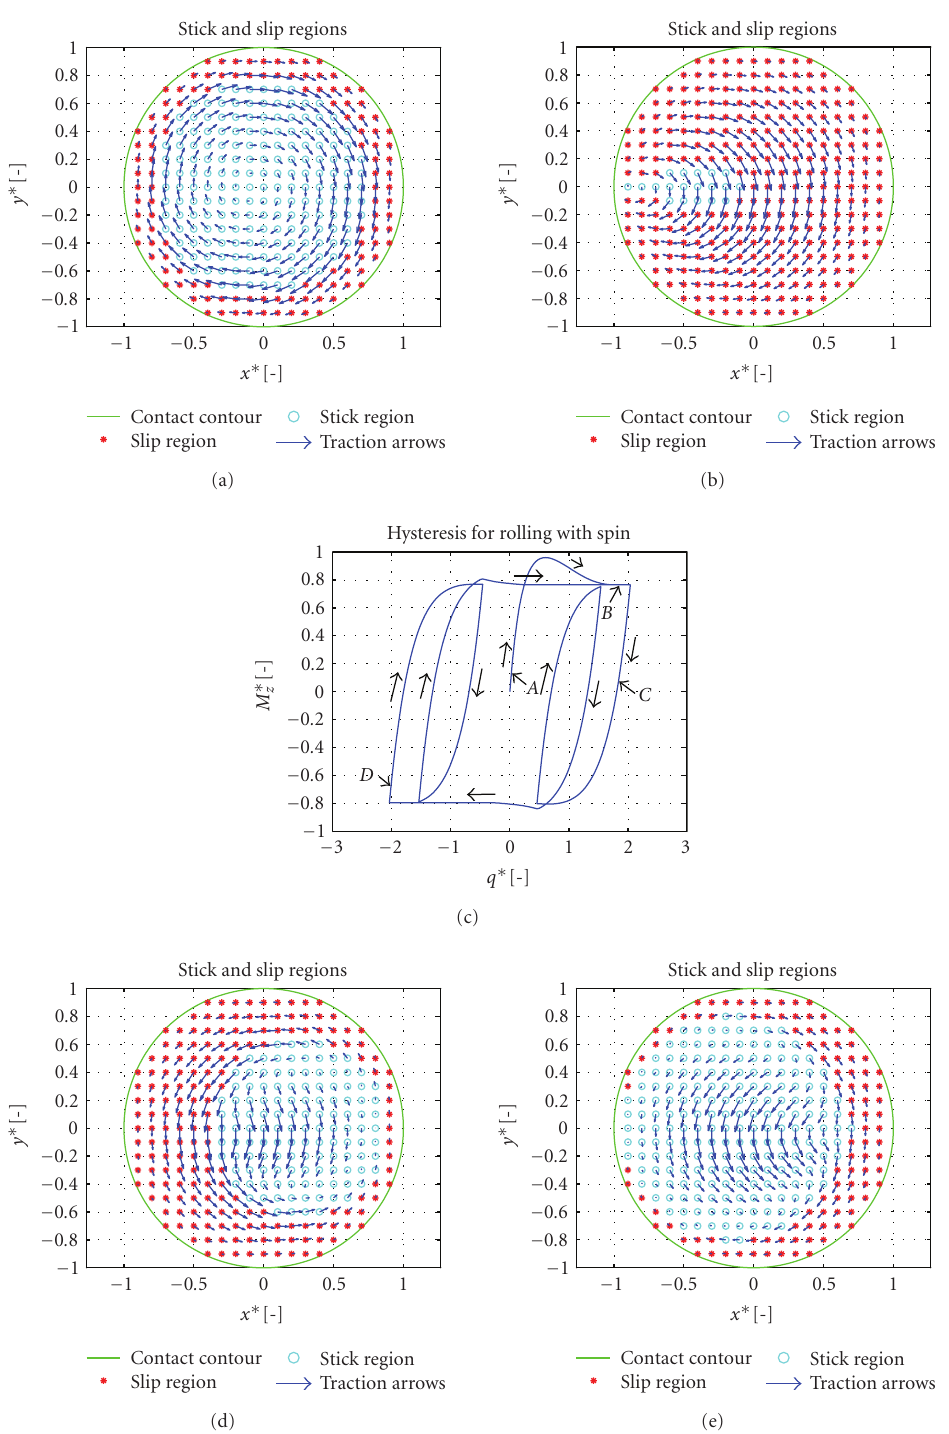
Figure 12: The results for transient (pre-)rolling with spin. In the middle, the hysteresis with around it, some transient traction fields at selected points in the